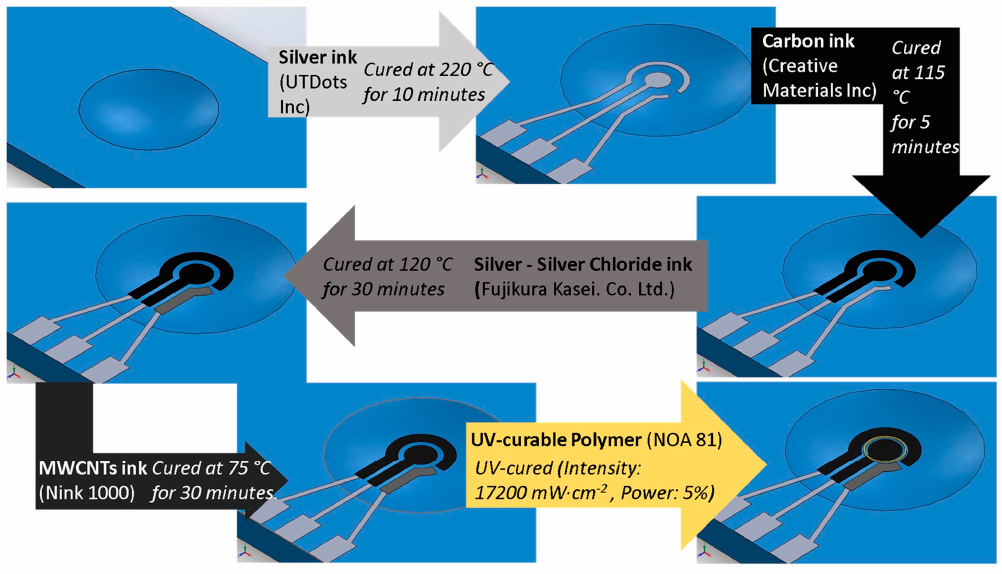
Figure 2. AJP process for sensor fabrication.